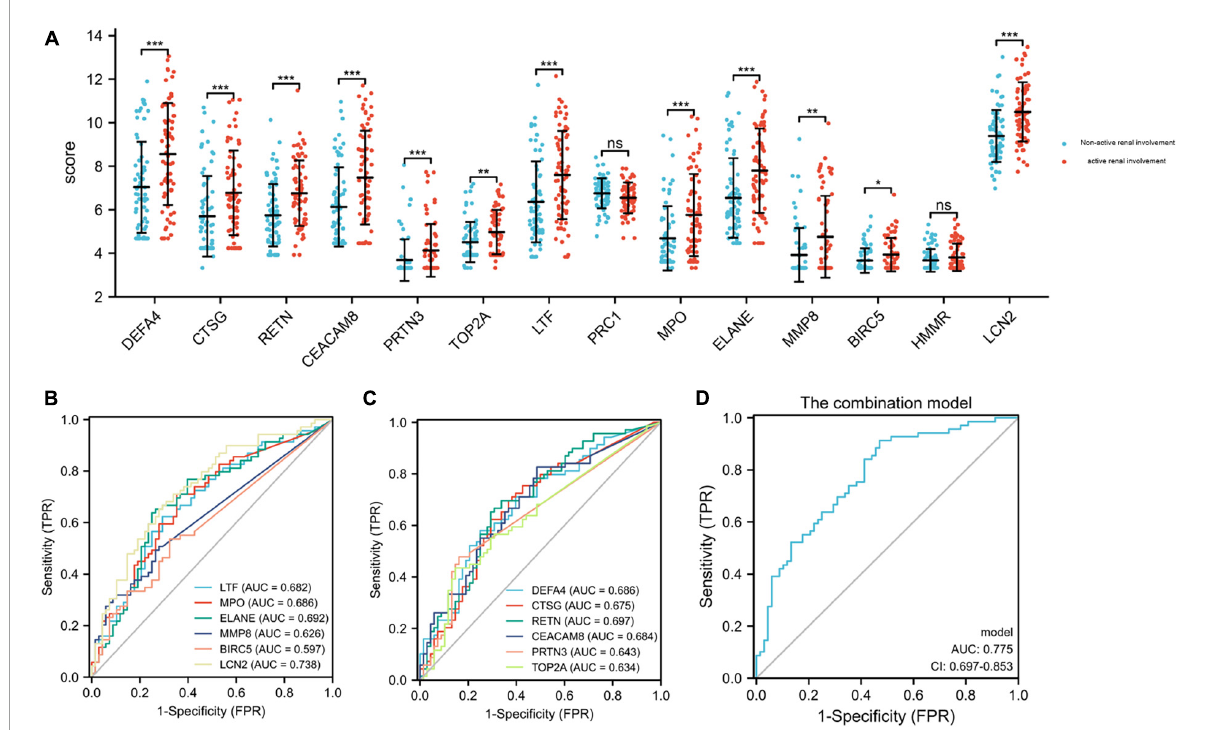
FIGURE6 Expression level of hub genes in GSE65391 and ROC curves of the 12 identified and verified hub genes. (A) The verification of hub genes in GSE65391. The comparison between the two sets of data with the mean T test. Except PRC1 and HMMR, the expression levels of other 12 hub genes were verified in GSE65391. (B,C) The ROC curves of the 12 hub genes. (D) The ROC curve of the combination model of the 12 hub genes. RStudio (https://www.R-project.org) was used in statistical analysis. P value < 0.05 was considered statistically significant. * P < 0.05; ** P < 0.01; *** P <